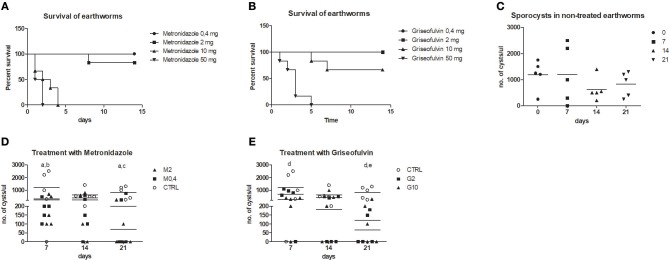
Treatment of parasitic infection by metronidazole and griseofulvin. Earthworms were treated with two types of antibiotics in a concentration range (0.4–50 mg/worm: M0.4,−50, G0.4-50) during 15 days and earthworm survival as well as the number of sporocysts were evaluated. (A) survival after the metronidazole treatment, (B) survival after the griseofulvin treatment, all control worms without any treatment survived (not shown in the graphs) (C) number of sporocysts in non-treated earthworms, (D) number of sporocysts in seminal vesicles after treatment with 0.4 and 2 mg/worm of metronidazole, (E) number of sporocysts in seminal vesicles after treatment with 2 and 10 mg/worm of griseofulvin. The significance was evaluated by one-sample t-test in the GraphPad Prism software. Different letters indicate significant differences between treatments and controls: a- M0.4 (P < 0.05); b- M2 (P < 0.05); c-M2 (P < 0.001); d- G2 (P < 0.01), e- G10 (P < 0.01).